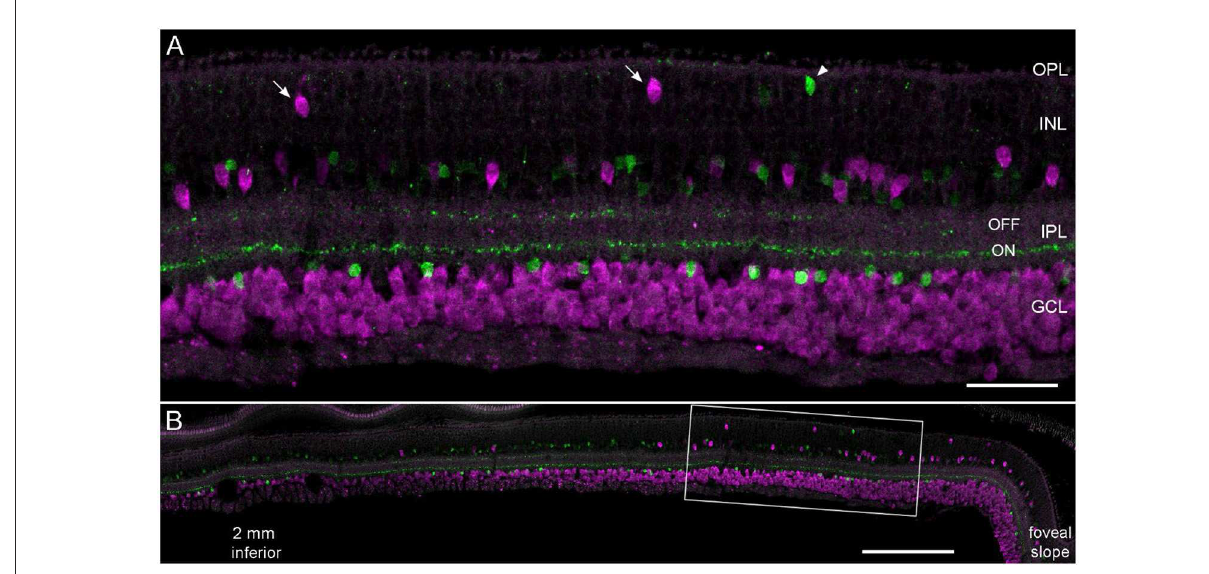
FIGURE1 Displaced retinal ganglion cells in the central marmoset retina. Vertical vibratome section of an 11-year-old male double labeled with antibodies against RBPMS (magenta) and ChAT (green). (A) Confocal image of the central retina at about 0.8mm inferior. Arrows mark displaced magenta RGCs; the arrowhead shows a misplaced SAC. (B) Same section at lower magnification showing the retina from 2.2mm inferior to the foveal slope. Scale bar 50 µ m for (A) and 200 µ m for (B)